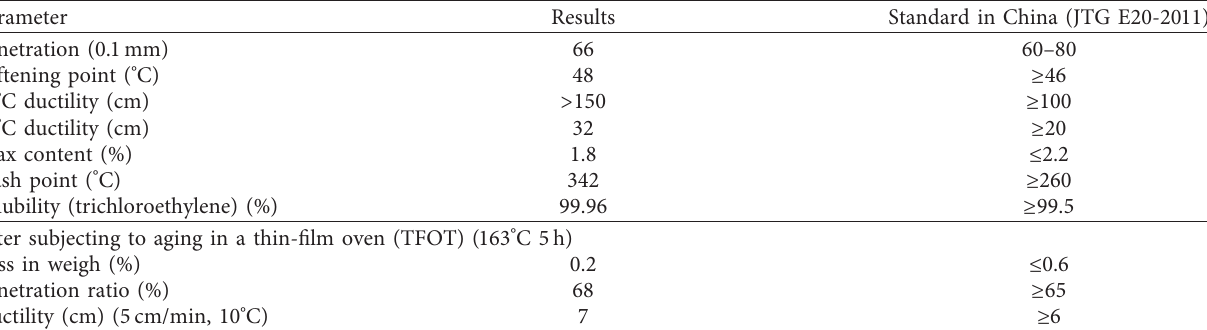
Table 1: Technical indexes of 70# A road asphalt.